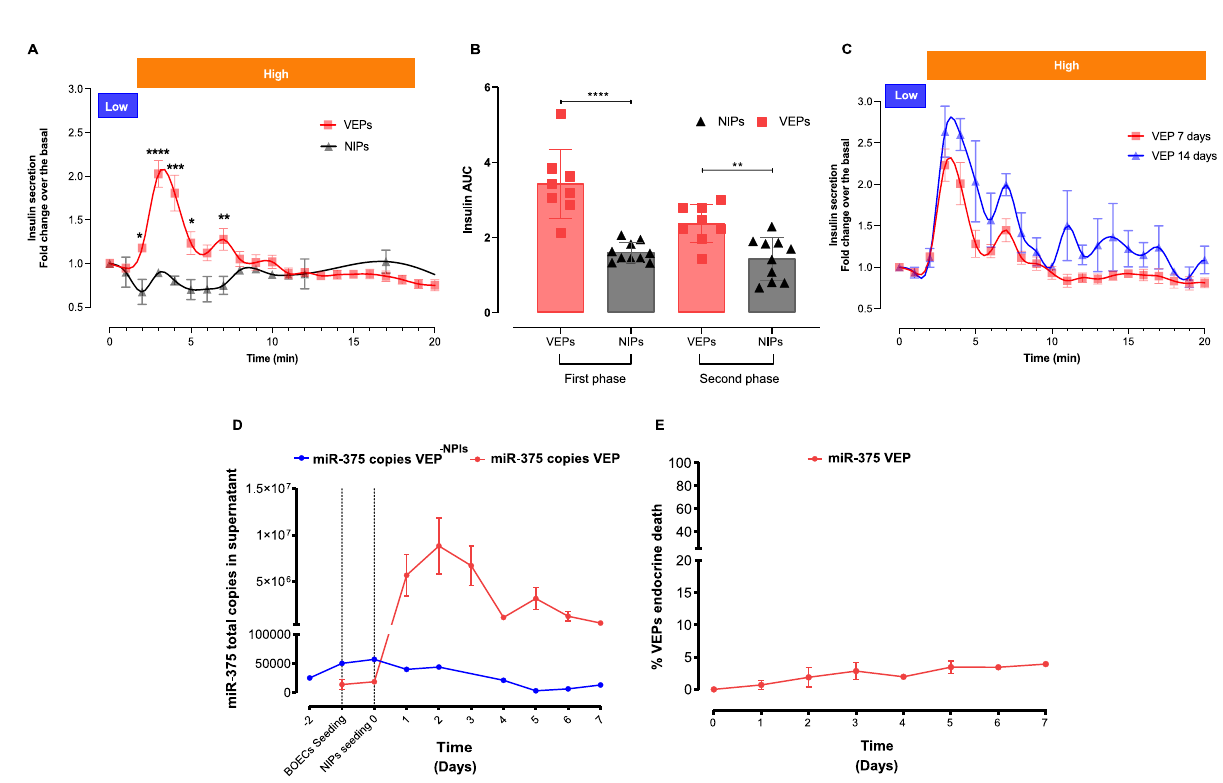
Fig.3|ExvivofunctionalevaluationofVEPs.A Insulinsecretiontest(IST)ofVEPs (red line, n =8 scaffolds) vs . NPIs (black line, n =10, NPIs preparations) after 7 days of culture in the presence of low (2mM) and high (20mM) glucose. Values are expressed as fold change over the basal. (VEP vs . NPIs min 2 * p =0.026; min 3 **** p <0.0001; min 4 *** p =0.0002; min 5 * p =0.0155; min 7 ** p =0.0085, Mann- Whitney U test) Values presented as mean±SEM. B Area Under the Curve (AUC) analysisofIST.AnalysisofVEPs( n =8scaffolds)andNPIs( n =10NPIspreparations) performancewithin fi rstandsecondinsulinsecretionphaseafterglucosestimulus. AUC VEP fi rst phase: 3.43±0.9; second phase: 2.37±0.5; AUC fi rst phase